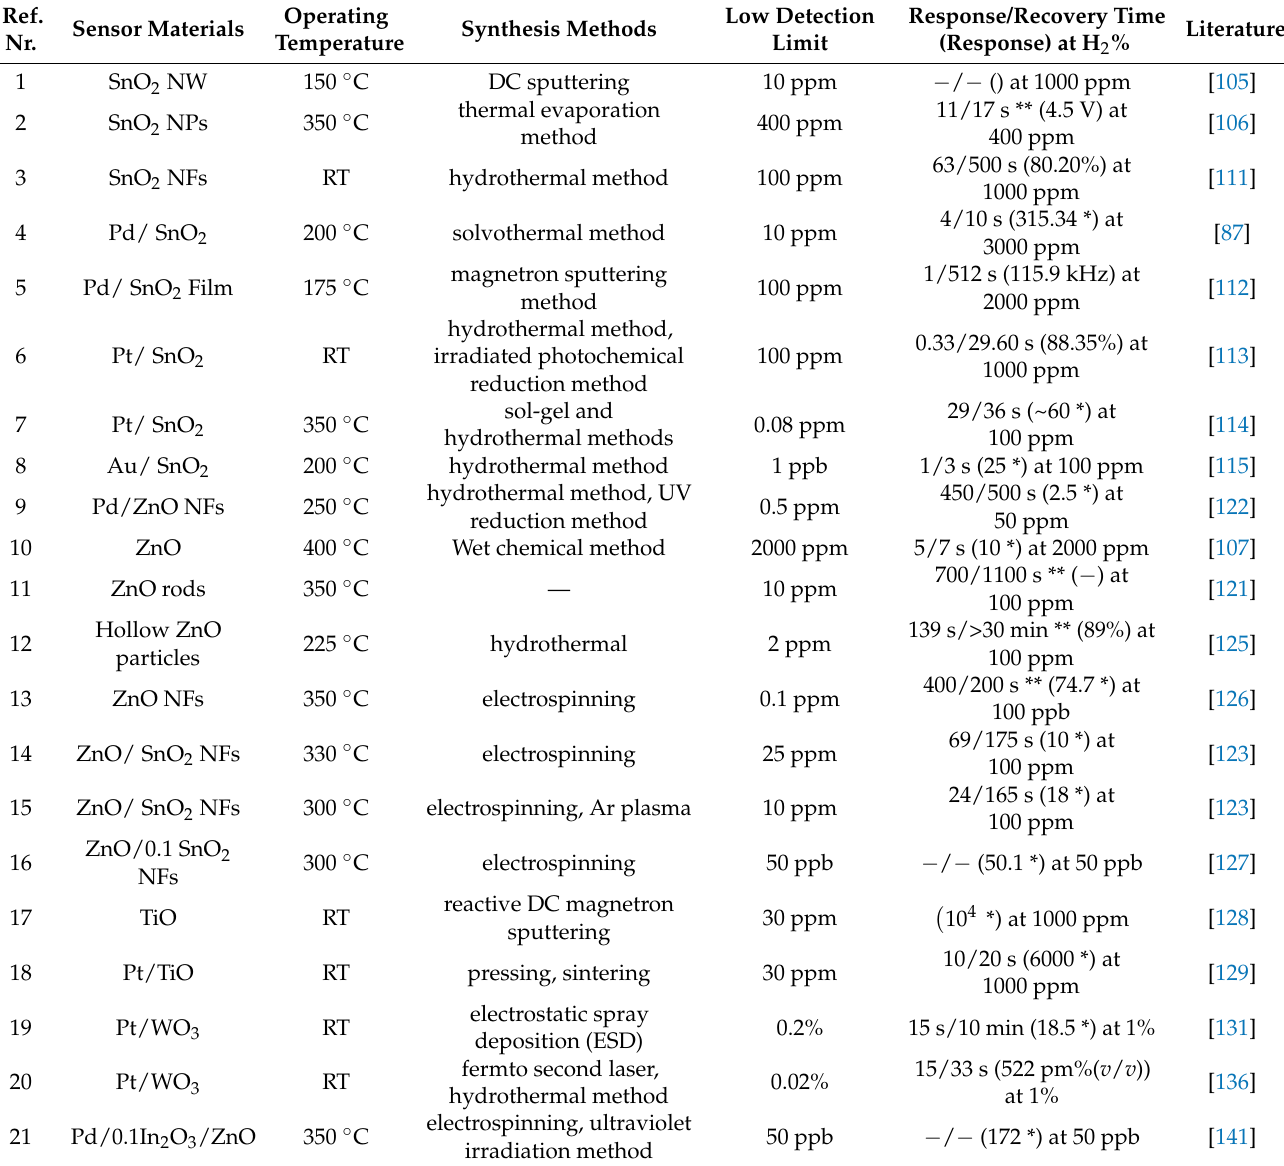
Table 2. Comparison of sensing performances towards hydrogen gas of metal oxide semiconductor (MOS)-based gas sensors in the literature. Unless specified, the sensor response is defined by the given Equation (1). (*) Sensor response given by the form R a /R g . (**) The recovery times were not given directly in their publications and were approximately read out from the sensing response curves. RT: room temperature, DC: direct current.